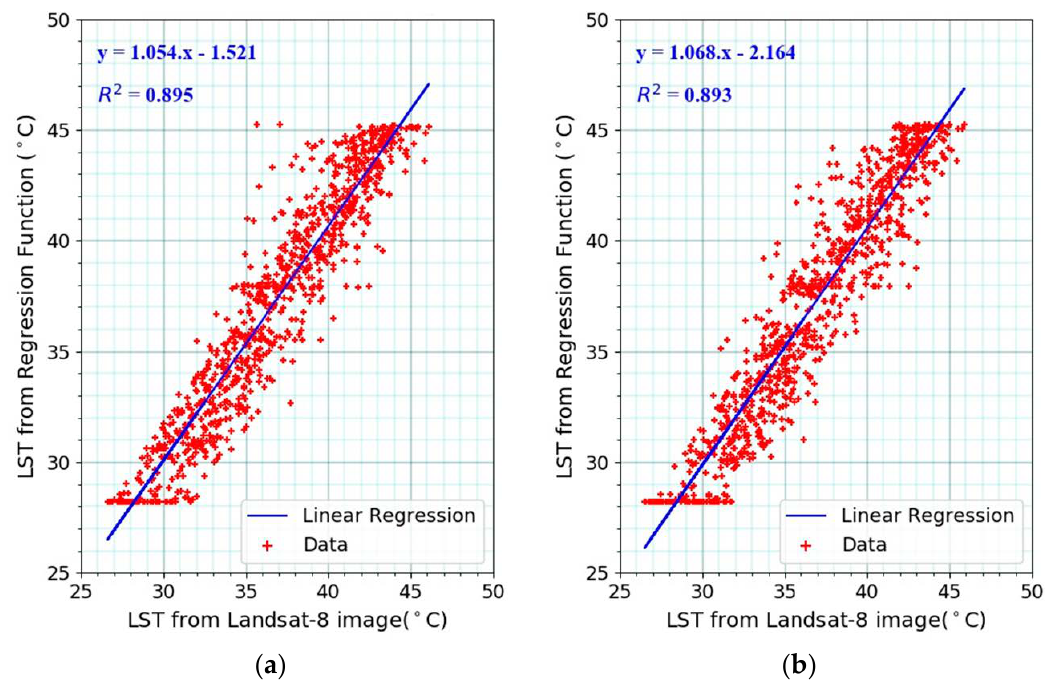
Figure 9. Land-use composition–driven predictions of LST for the hottest day of 2017 (4 June) versus LST observed by Landsat-8 for ( a ) 510 × 510 m and ( b ) 330 × 330 m window sizes.